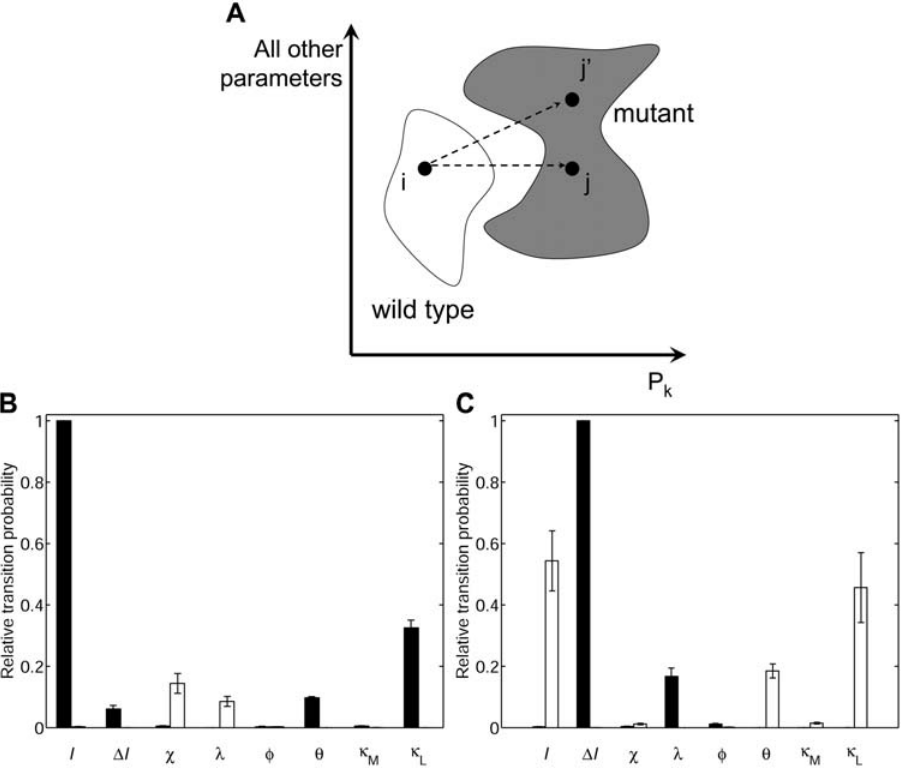
Figure 4. Quantitatively predicting the optimal molecular perturbations needed to generate specific mutant phenotypes. (A) Schematic for counting phenotype transitions made possible by single mutations. Subspaces in the 8-dimensional parameter space are occupied by different phenotypes. This diagram portrays a simplified version of the phenotype phase diagram with a single parameter P k isolated on the x -axis and all other parameters denoted on the y -axis. The transition from i R j can occur by a change in a single parameter P k , but the transition i R j 9 cannot. By counting the number of successful single mutations (i R j) for each parameter P k , we quantify the relative efficacy of each parameter to render a specific phenotype transition (W R M) (see also Materials and Methods). (B,C) The relative probability of inducing a transition from the wild- type phenotype to the 3 u 3 u 3 u 3 u 3 u 3 u phenotype (B) or the the hyperinduced 2 u 1 u 2 u 1 u 2 u 1 u phenotype (C) by decreasing (filled columns) or increasing (open columns) the values of parameters indicated on the x -axis. The y -axes report the mean relative transition probability averaged over a broad combination of threshold values for fate-determining signals, and the error bars denote the standard deviation (see also Materials and Methods). The size of the error bar reveals that model predictions are robust to variations in the threshold values of fate-determining